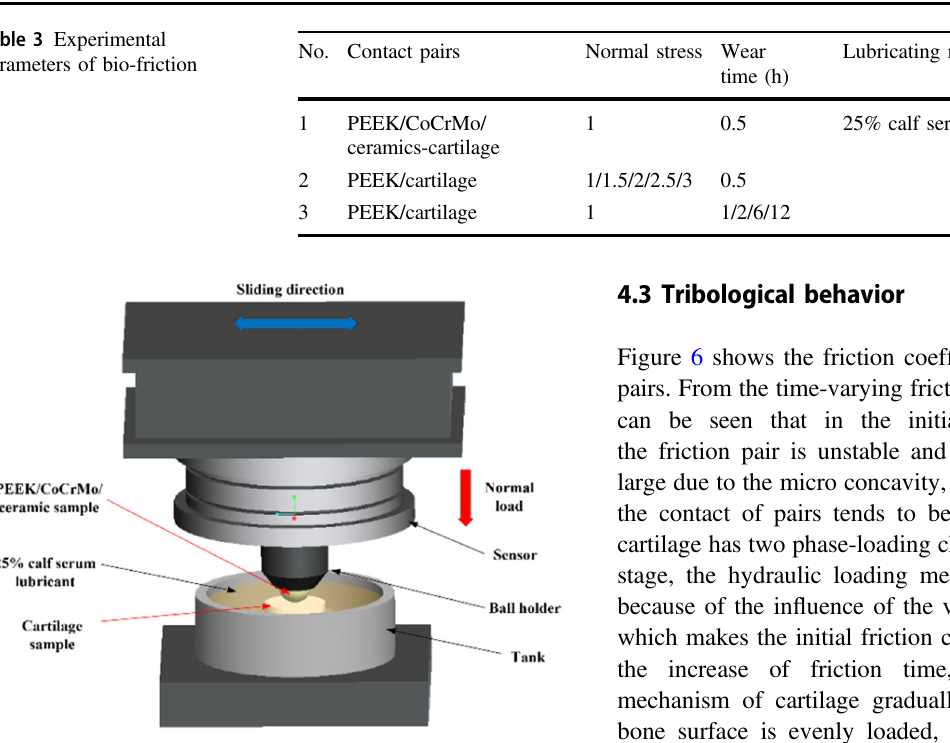
Fig. 2 Sliding friction experimental device